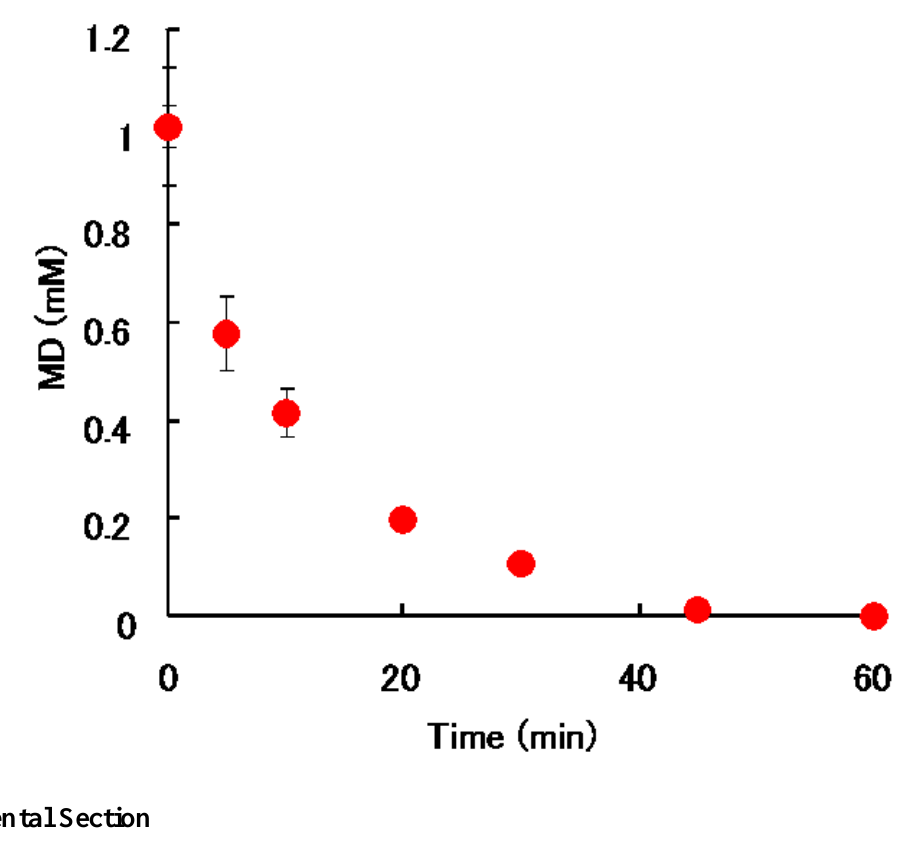
Figure 4. Alterations in concentration of MD in banana supernatant (BS) solution (1m M) at 30 °C at 0, 5, 10, 20, 30, 45, and 60 min after the addition of MD. Each point and vertical bar represents the mean ± SD of three